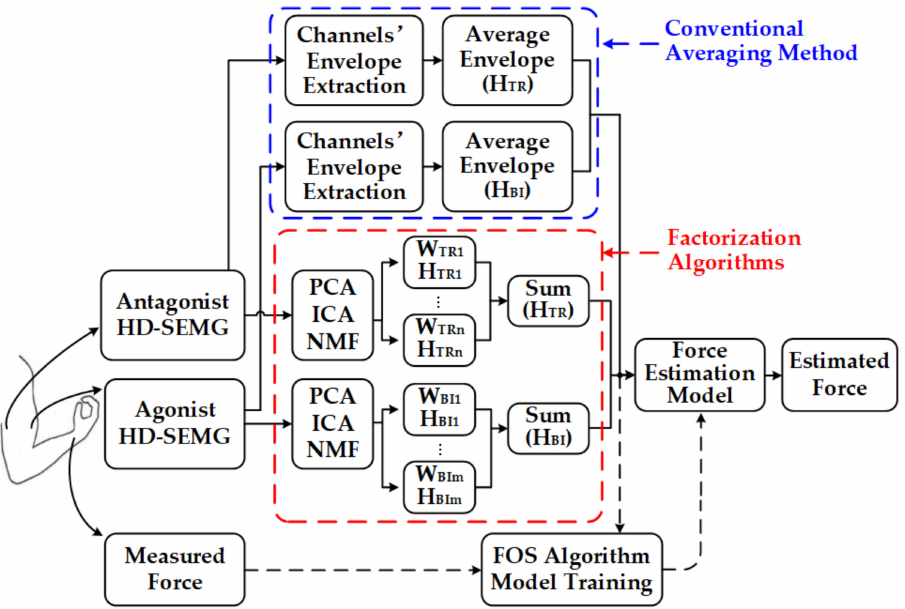
Figure 1. Block diagram of FOS-based HD-SEMG-force estimation framework. ( W : activation pattern, H : activation